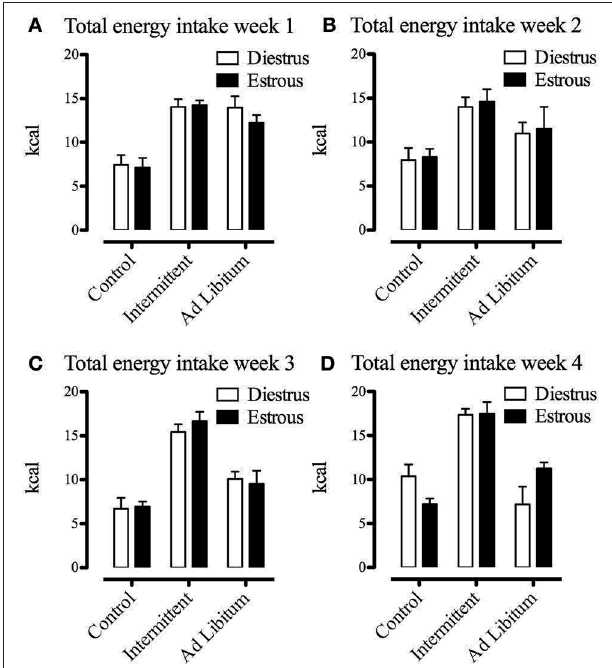
FIGURE 6 | Effects of estrous phase on total energy intake (chow + sucrose) of animals differentially exposed to the sucrose solution after 1 (A) , 2 (B) , 3 (C) , and 4 (D) weeks from the beginning of the protocol ( n = 7–12). Food and sucrose solution intake was measured in grams during a 2-h period, converted to kcal and expressed as means ± S.E.M.